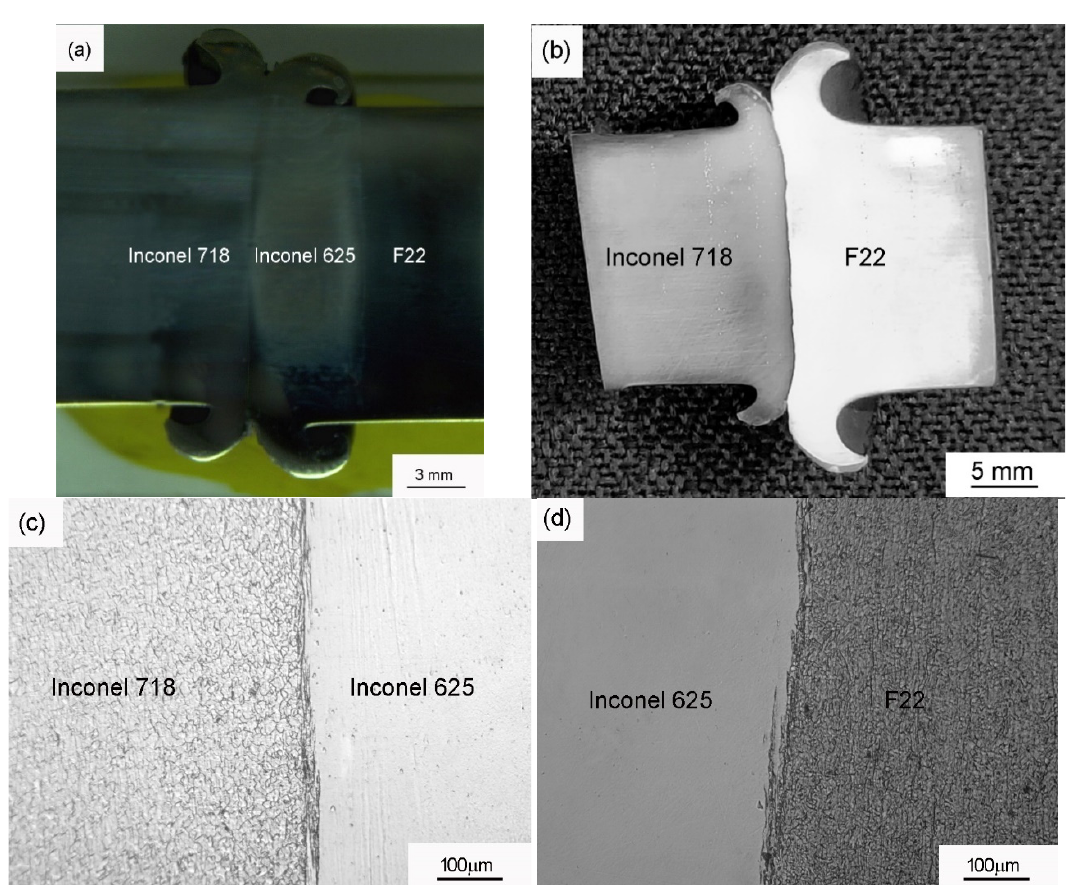
Figure 5. The macrograph of the F22-718 friction weld joint ( a ) with 625 interlayer, ( b ) without 625 interlayer, optical micro graph of ( c) 718/625 weld interface, and ( d ) 625/F22 weld interface.